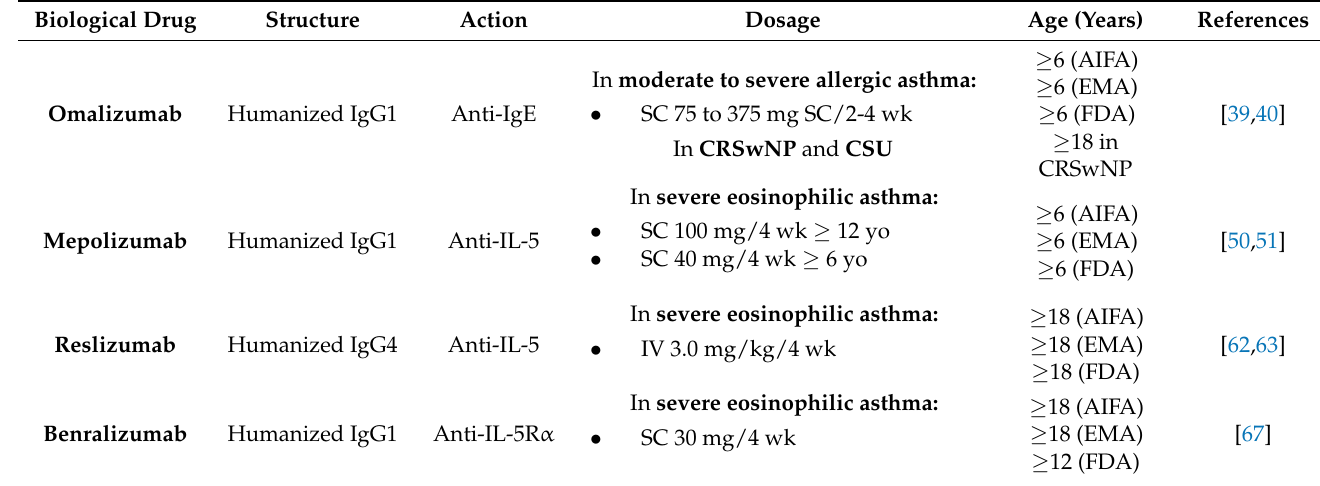
Table 1. Main Biologic Drugs currently approved in the pediatric